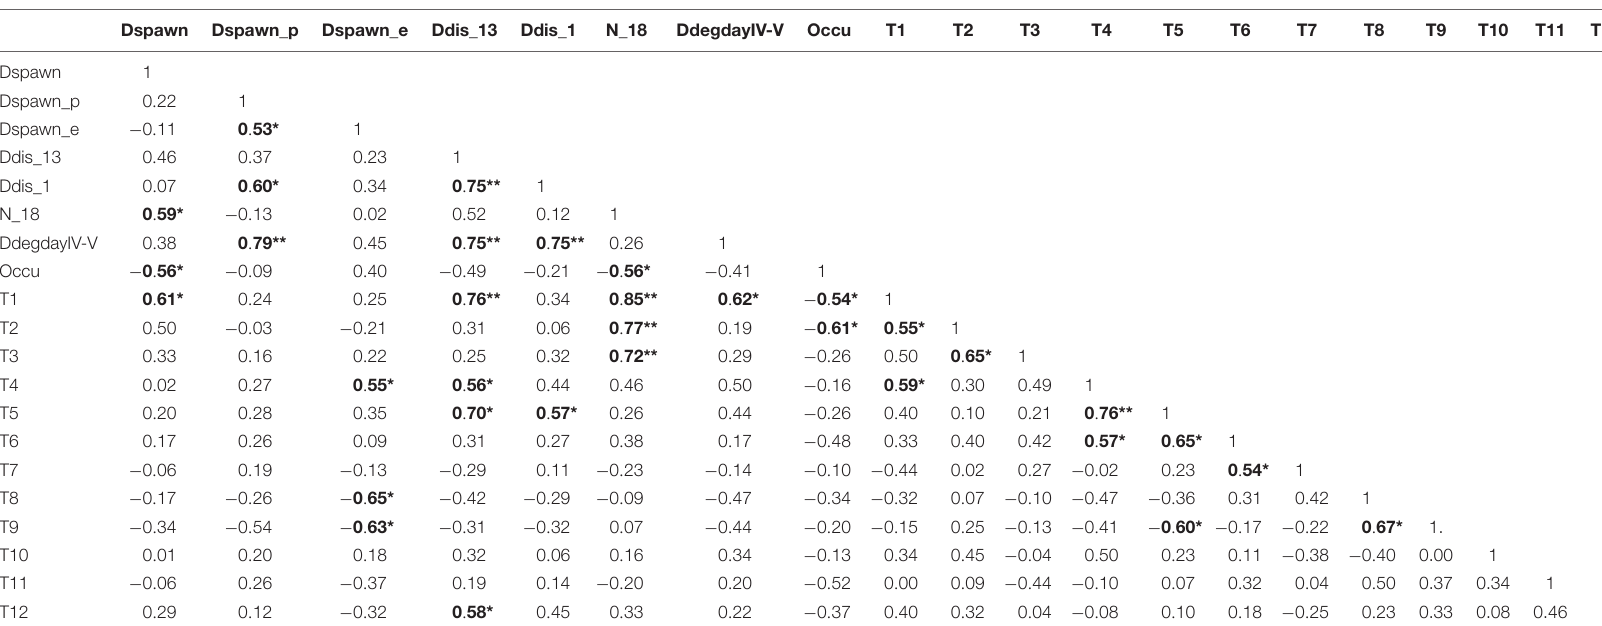
TABLE 1 | Pearson correlation coefficients among thermal, discharge, and spawning timing variables in the Pearl River (China) during 2006–2013 and